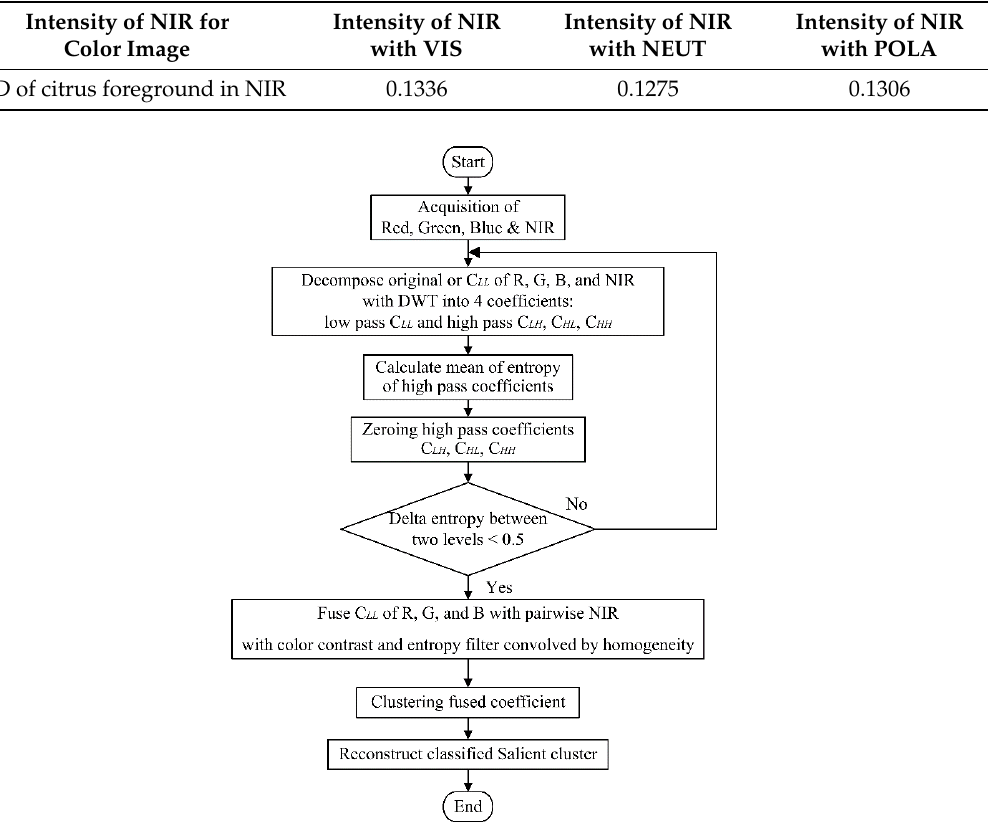
Figure 4. Scheme of fusion approach using RGB and NIR components.